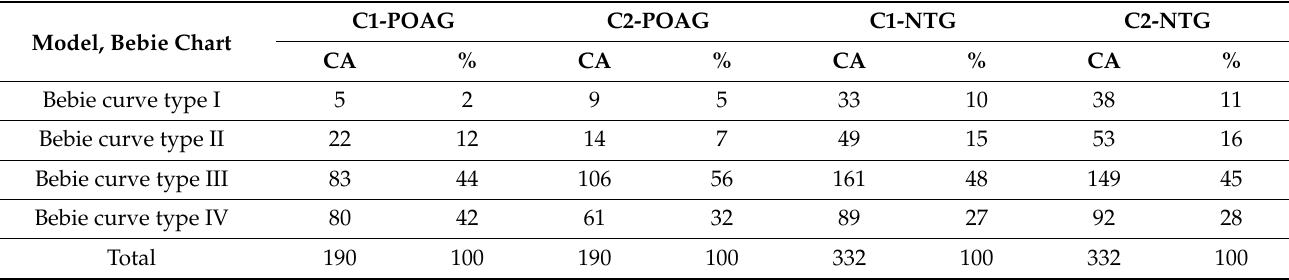
Table 7. Distribution of the types of “Bebie Curve” indicators of the centralized defect resulting from the examination of the “visual field” for patients with POAG and NTG.